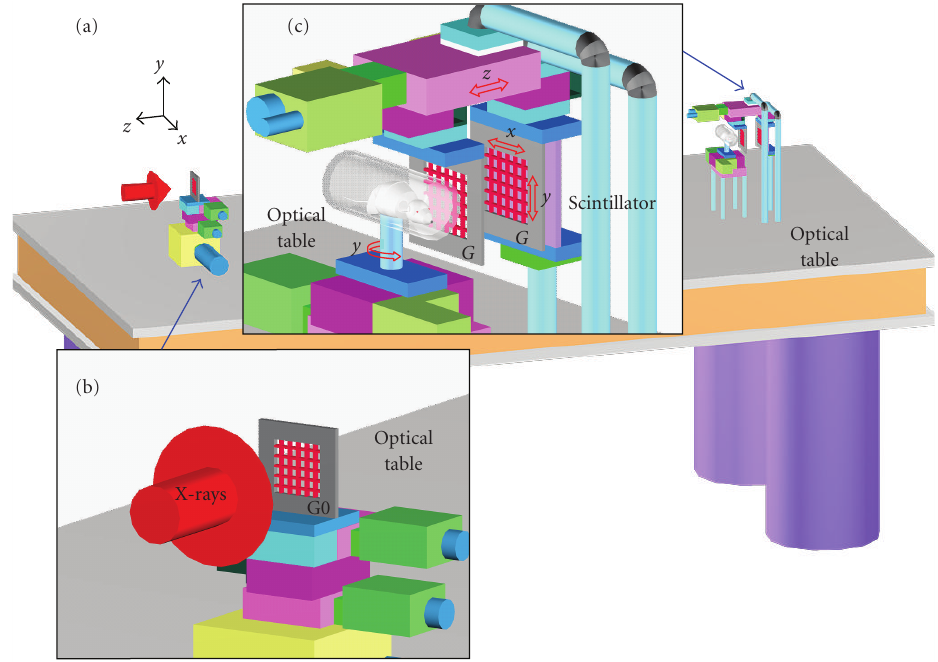
Figure 1: Schematics of our 2D grating-based phase-contrast image system. See the text for detailed configuration. Note that the scales of the grating features are exaggerated for